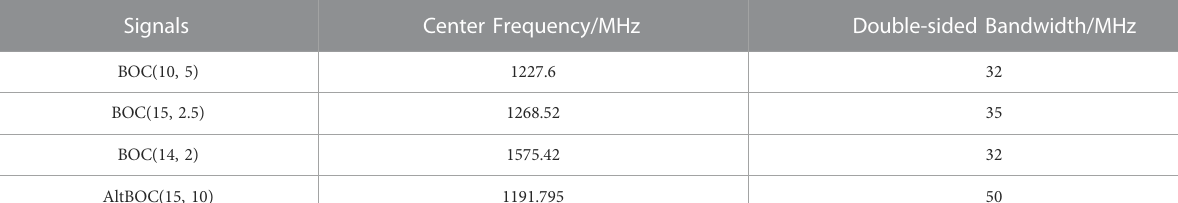
TABLE 1 Center frequency and double-sided bandwidth of the new generation GNSS signals.